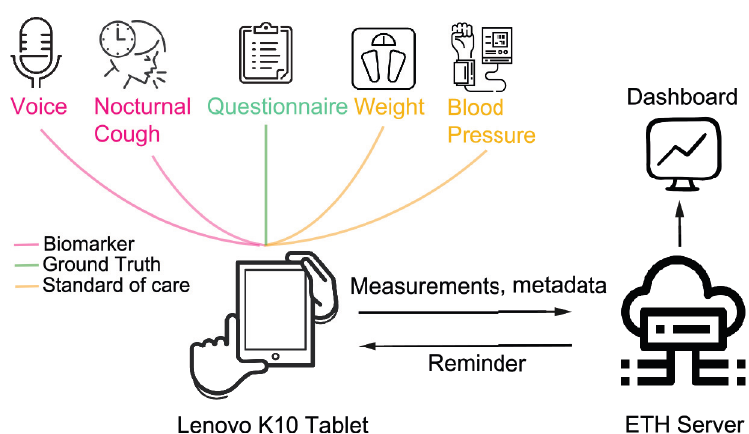
Fig 1. Data pipeline. Patients collect data every morning using the developed application on the Lenovo K10 tablet. All active measurements and nocturnal cough frequency are collected and transmitted to the ETH web server. The server integrates new data into the cloud and schedules reminders. Based on the data on the server, the dashboard visualizes and monitors measurements and metadata.